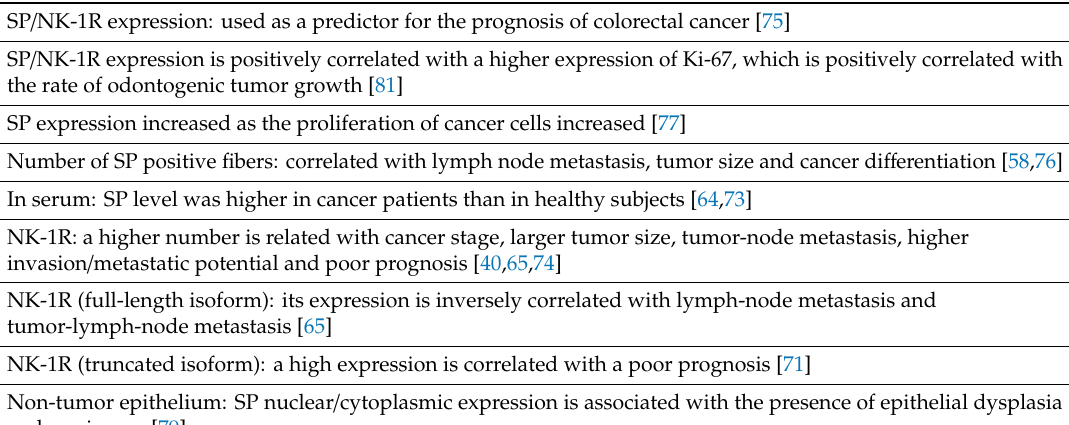
Table 1. SP / NK-1R system as a predictive factor in